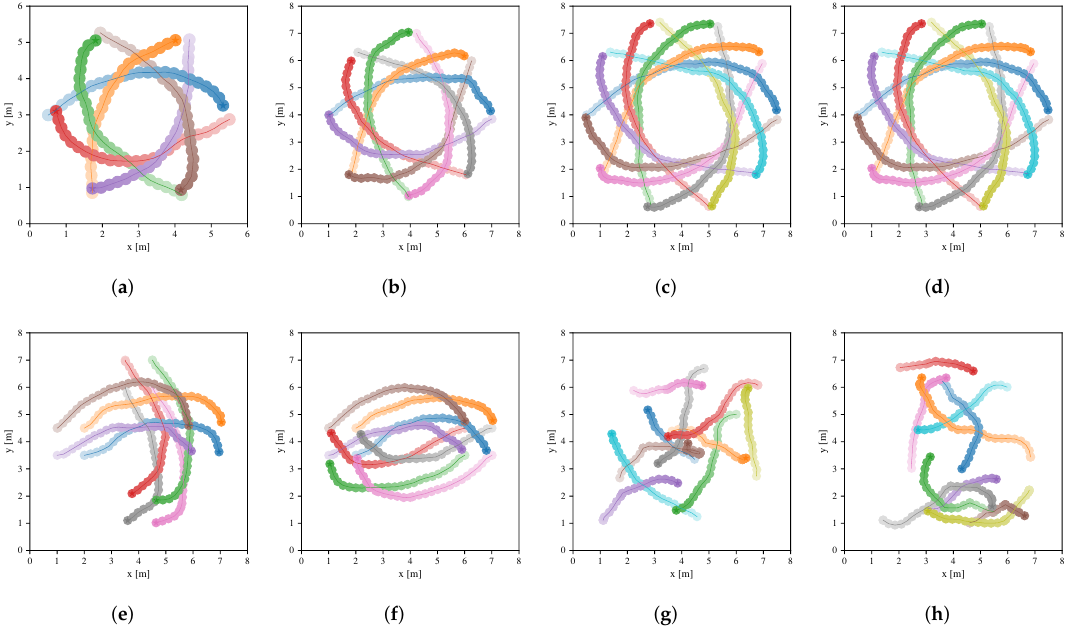
Figure 9. Trajectories of robots executing Sensor-level policy in environments of the circle scenario ( a – d ), cross scenario ( e ), swap scenario ( f ) and new random scenario ( g , h ), respectively. The trajectories of different robots are distinguished by different colors, and color transparency is used to indicate the time state along each trajectory.